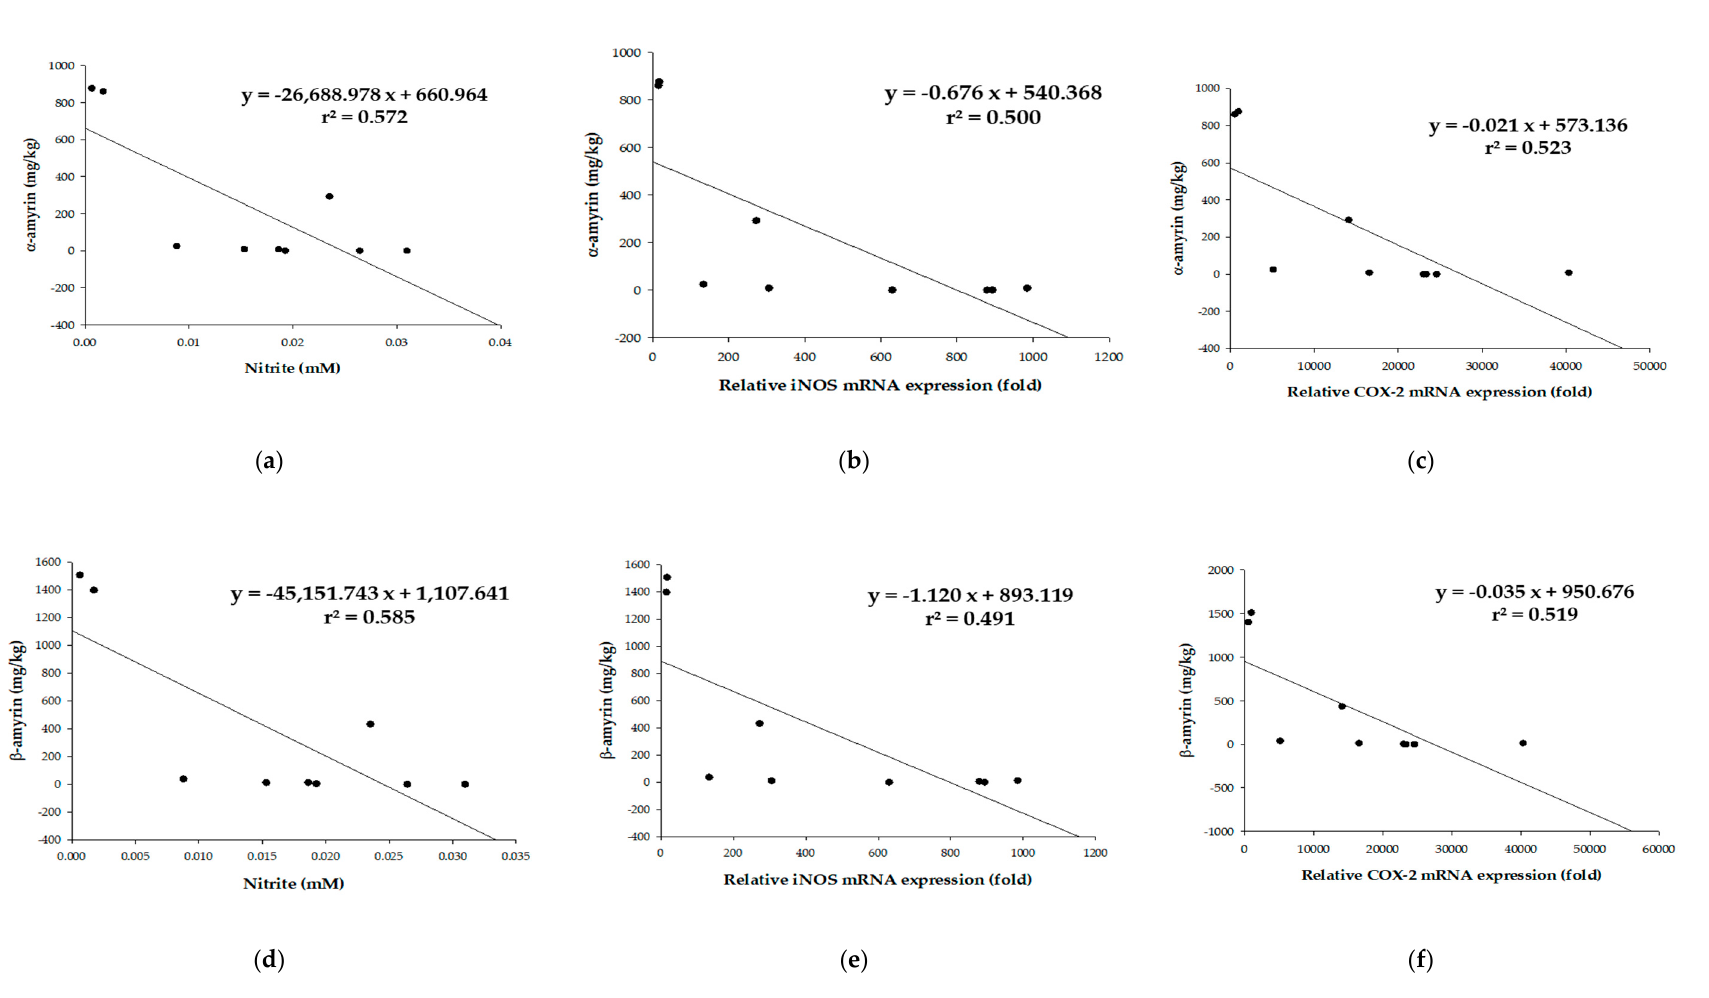
Figure 6. Relationship between amyrin and inflammation regulators. Correlations are presented as Pearson´s correlation coe ffi cient (r 2 ). The correlation between a-amyrin and nitrite ( a ), and the relative mRNA expression levels of inducible nitric oxide synthase (iNOS) ( b ) and cyclooxygenase-2 (COX-2) ( c ). The correlation between β -amyrin and nitrite ( d ), and the relative mRNA expression levels of iNOS ( e ) and COX-2 ( f